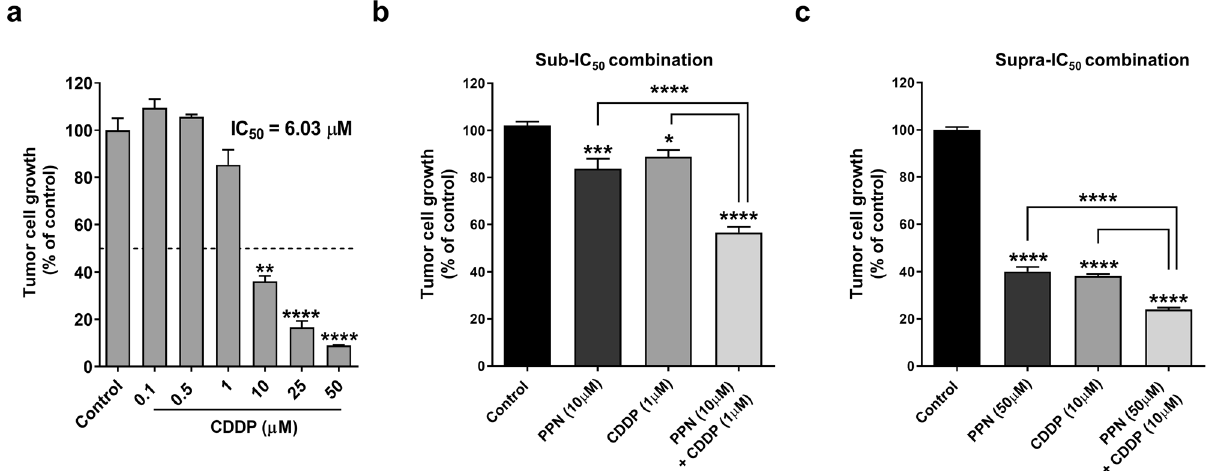
Figure 5. Cooperative growth-inhibiting activity of propranolol in combination with cisplatin in osteosarcoma cells. Tumor cell growth after propranolol (PPN) plus cisplatin (CDDP) combined treatment was evaluated on log-phase growing MG-63 cells and measured by crystal violet staining. ( a ) Impact of CDDP (0.1–50 μM) on OSA cell survival and IC 50 calculation after a 72 h exposure to tested compounds. Statistical significance (* p < 0.05) in growth inhibition by CDDP was achieved with drug concentrations ≥ 10 μM. ( b ) and ( c ), potential cooperative effects between PPN and CDDP were assessed by combining different sub-IC 50 or supra-IC 50 concentrations of tested compounds. Data are presented as mean ± SEM and are representative of at least two or three independent experiments. * p < 0.05, *** p < 0.001, **** p < 0.0001. ANOVA followed by Tukey’s test for (a), (b) and